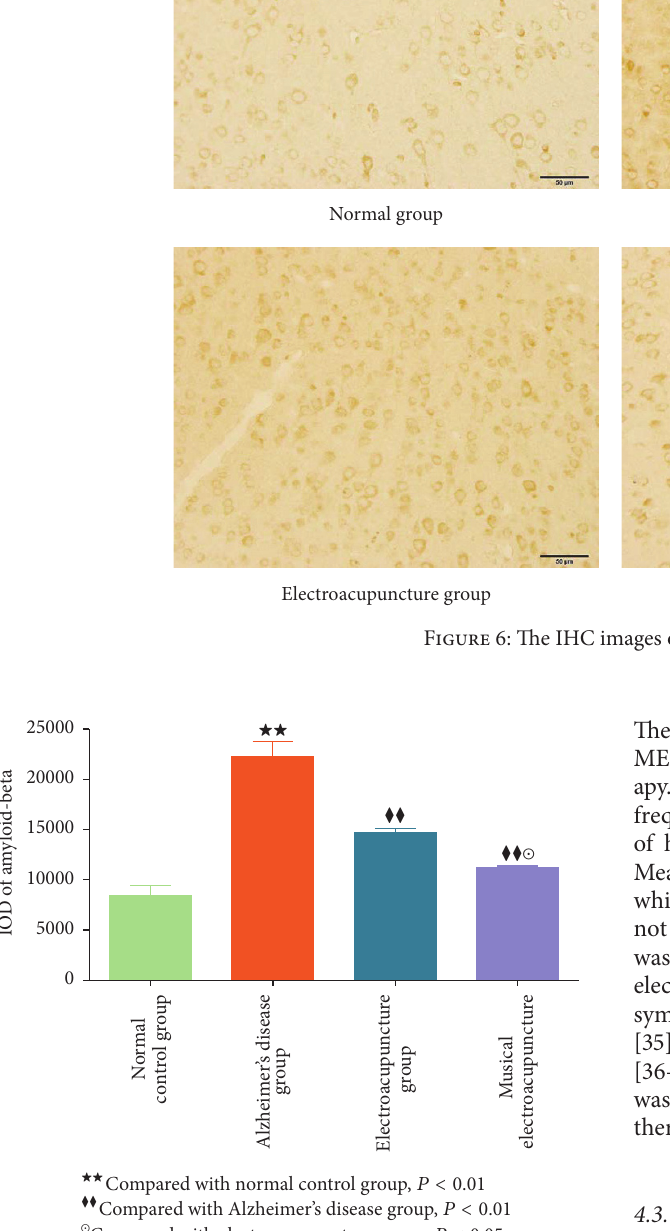
Figure 7: The IOD of amyloid-beta in frontal lobe of each group. substances (including brain norepinephrine and endogenous antiopioid substances) as well as large amounts of endoge- nous monoamine. Among them, cholecystokinin octapeptide (CCK-8) is by far the most recognized antiopioid contribut- ing to EA tolerance [30], which is caused by long-term use of the same frequency in EA. Since AD treatment requires a long-term course, it likely results in EA tolerance